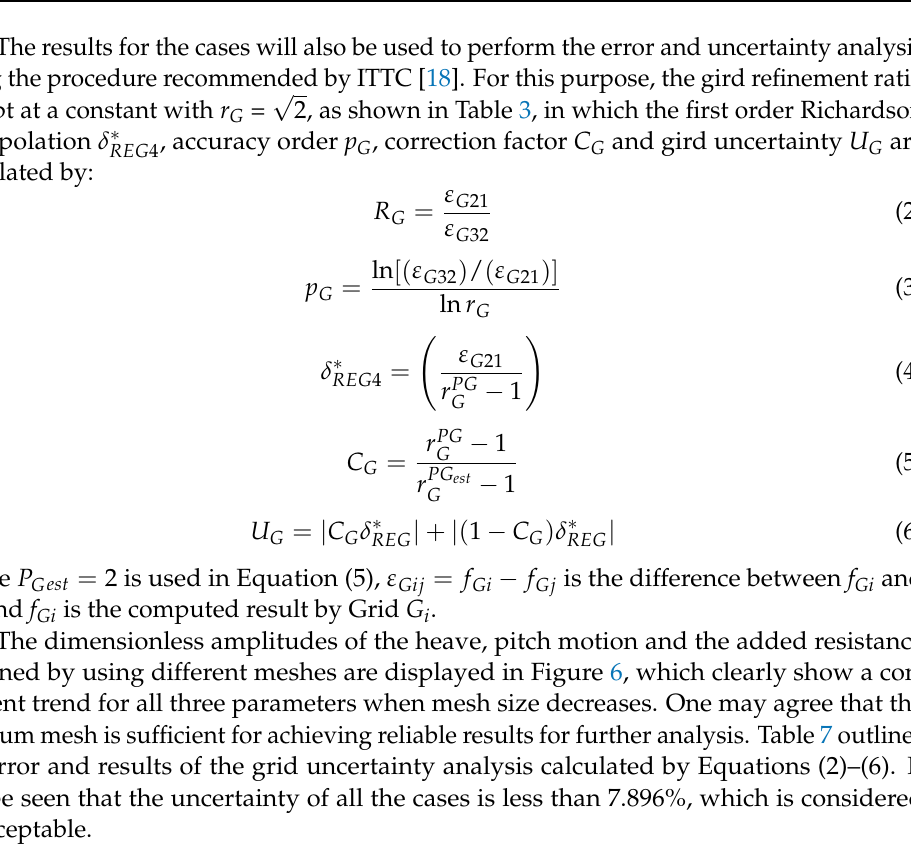
Table 7. Results of error and uncertainty